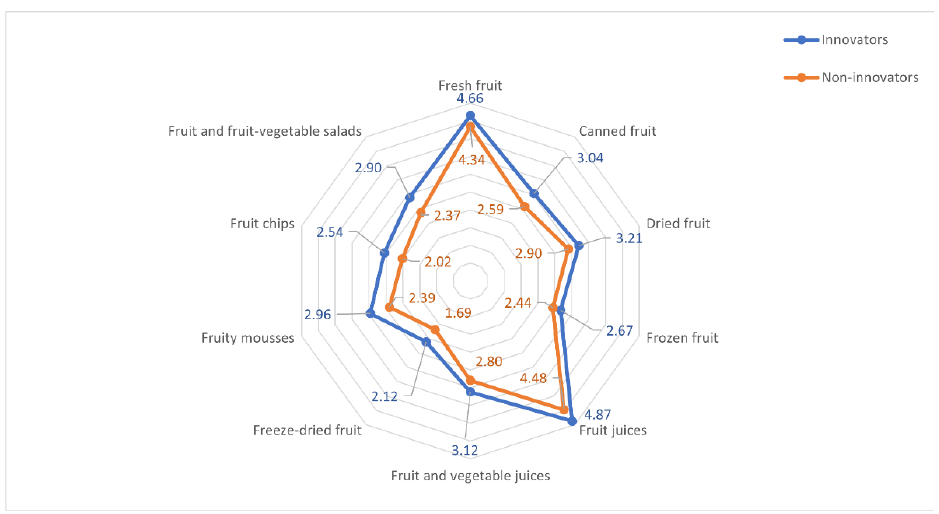
Figure 2. Frequency (On a scale of 1–7: 1—never; 2—less often than once a month; 3—1–3 times a month; 4—once a week; 5—several times a week; 6—once a day; 7—several times a day)of consuming fruits and fruit preserves of innovators and non-innovators.